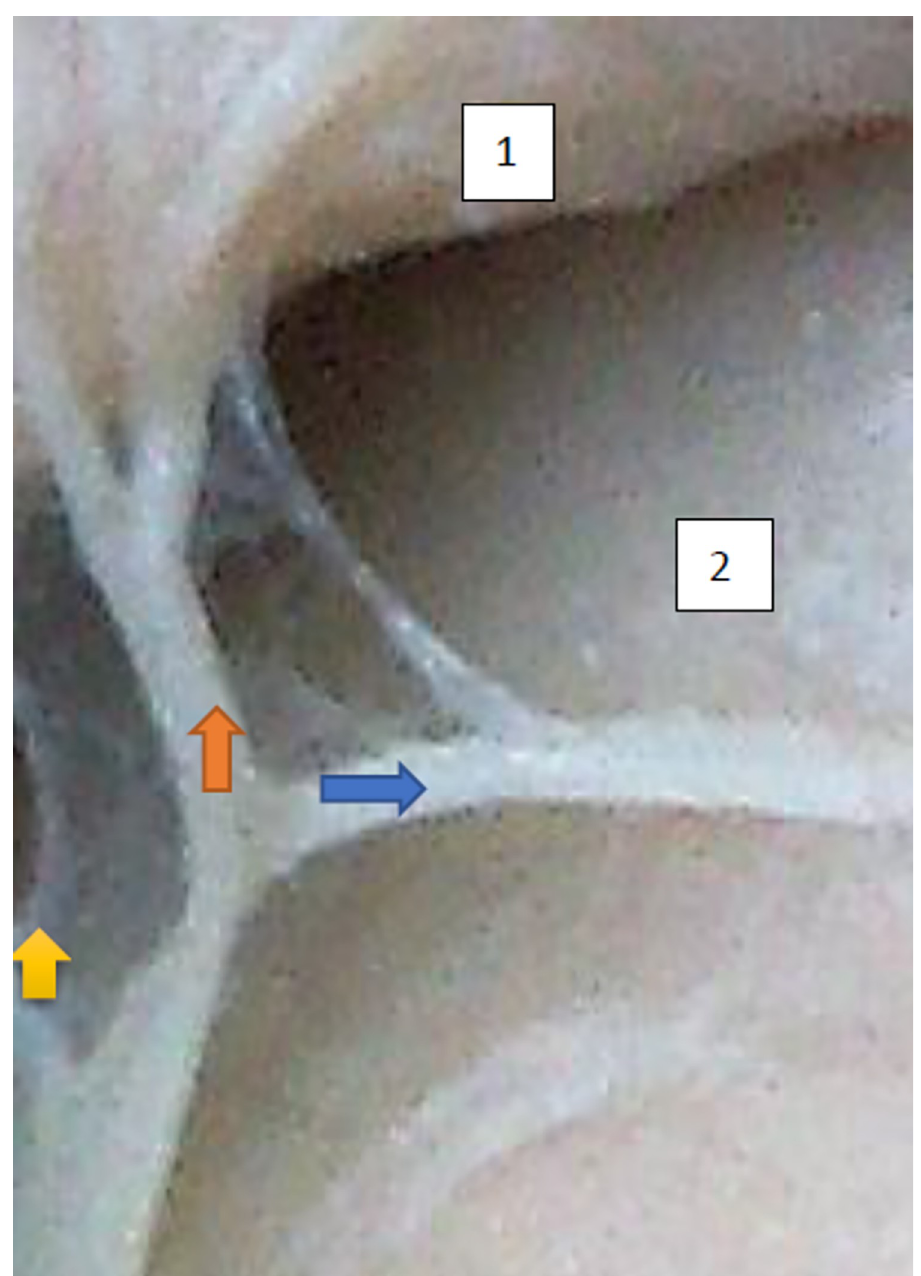
Fig 5. Superior gluteal nerve, tree type, morphological age150–22–VI, v–tub 182,v–pl 258, mass 140, female sex, magnification x30, 1– gluteus medius muscle, 2– gluteus minimus muscle, red arrow–branch to gluteus medius muscle, yellow arrow–branch to gluteus minimus muscle, blue arrow–branch to tensor fasiae latae muscle.